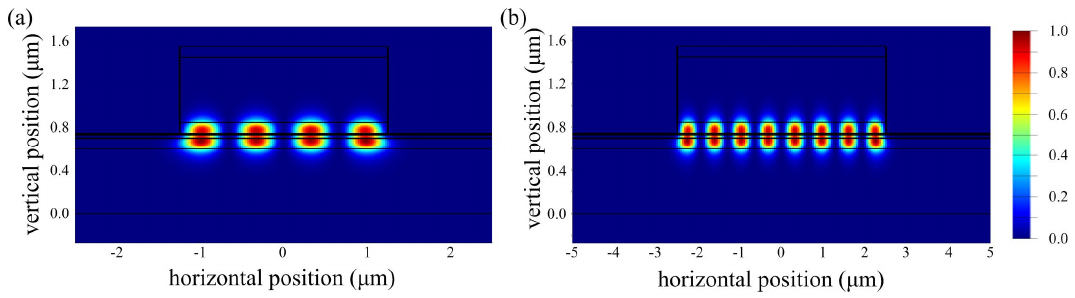
Figure 1 Optical field profiles for ridge widths of ( a ) 2.5 µm and ( b ) 5 µm. Figure 1. Optical field profiles for ridge widths of ( a ) 2.5 µ m and ( b ) 5 µ